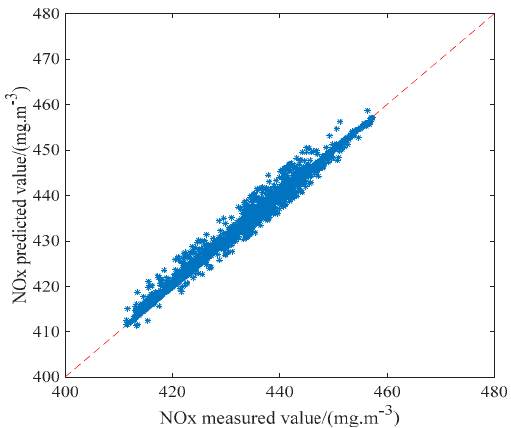
Figure 7. NO x comparison between predicted and measured values. Table 2. Evaluation Index of NO x emission Model Based on IDELM Algorithm.